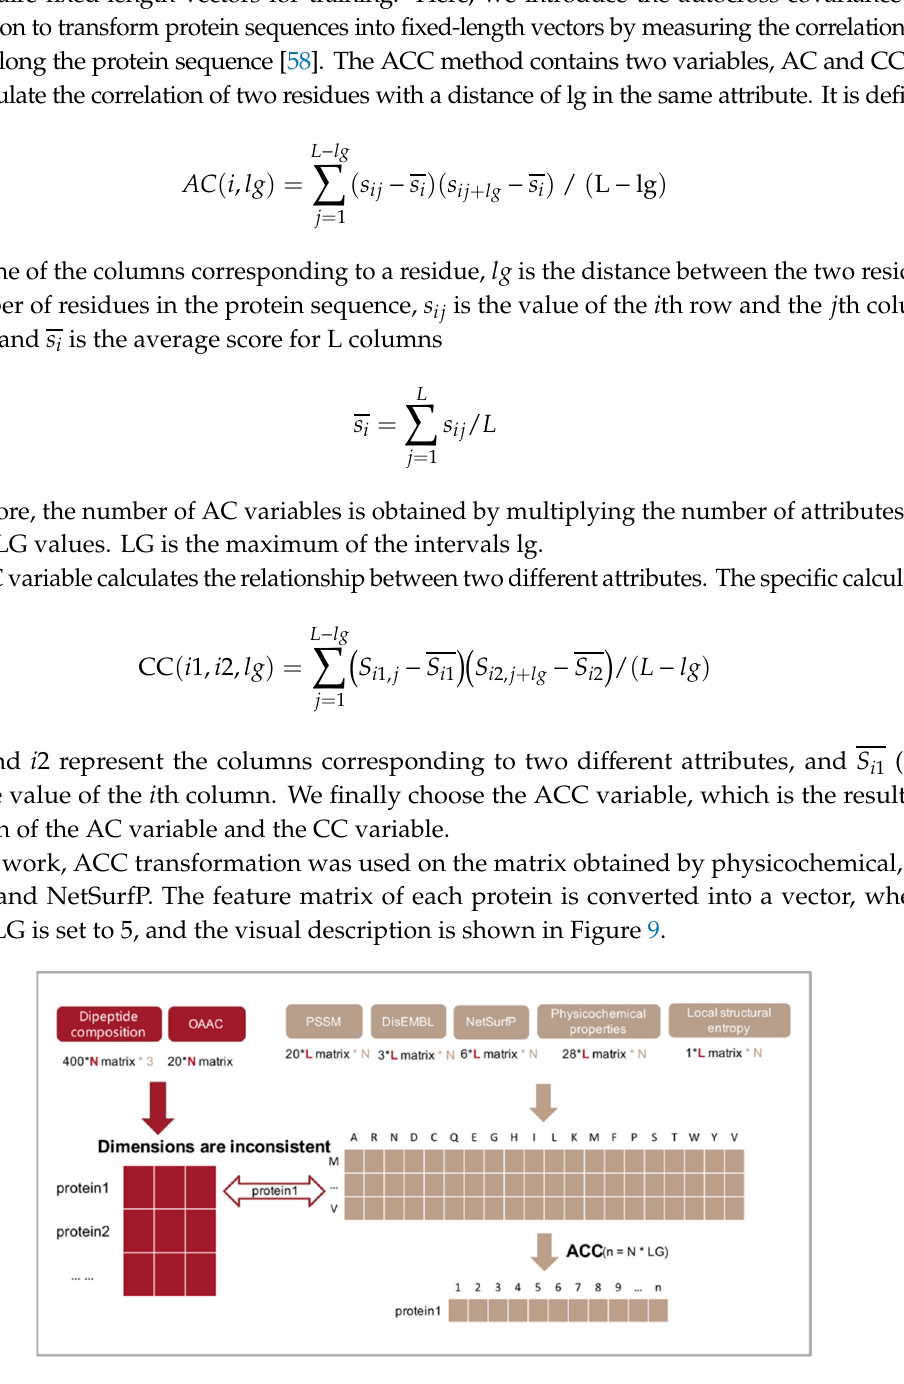
Figure 9. Application of the ACC transformation in this study. For example, protein1 refers to the name of a protein, and features extracted based on its sequence information are vectors, while others are matrices. In this case, the matrix can be converted to a vector.